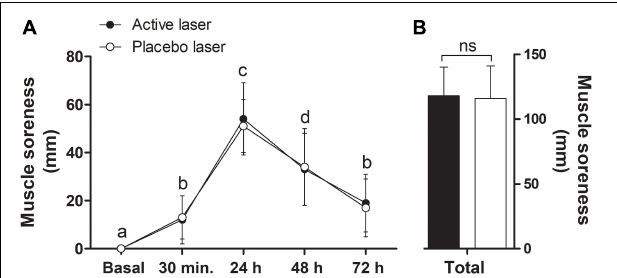
FIGURE 5 | Delayed onset muscle soreness (DOMS) during the recovery days (basal to 72 h postexercise) (A) and corresponding total DOMS (sum of all times) (B) in the active and placebo laser conditions ( N = 13). Data are means ± SD. There were no significant ( p > 0.05) differences over time between conditions. Different letters indicate significant ( p < 0.05) difference between time points for both